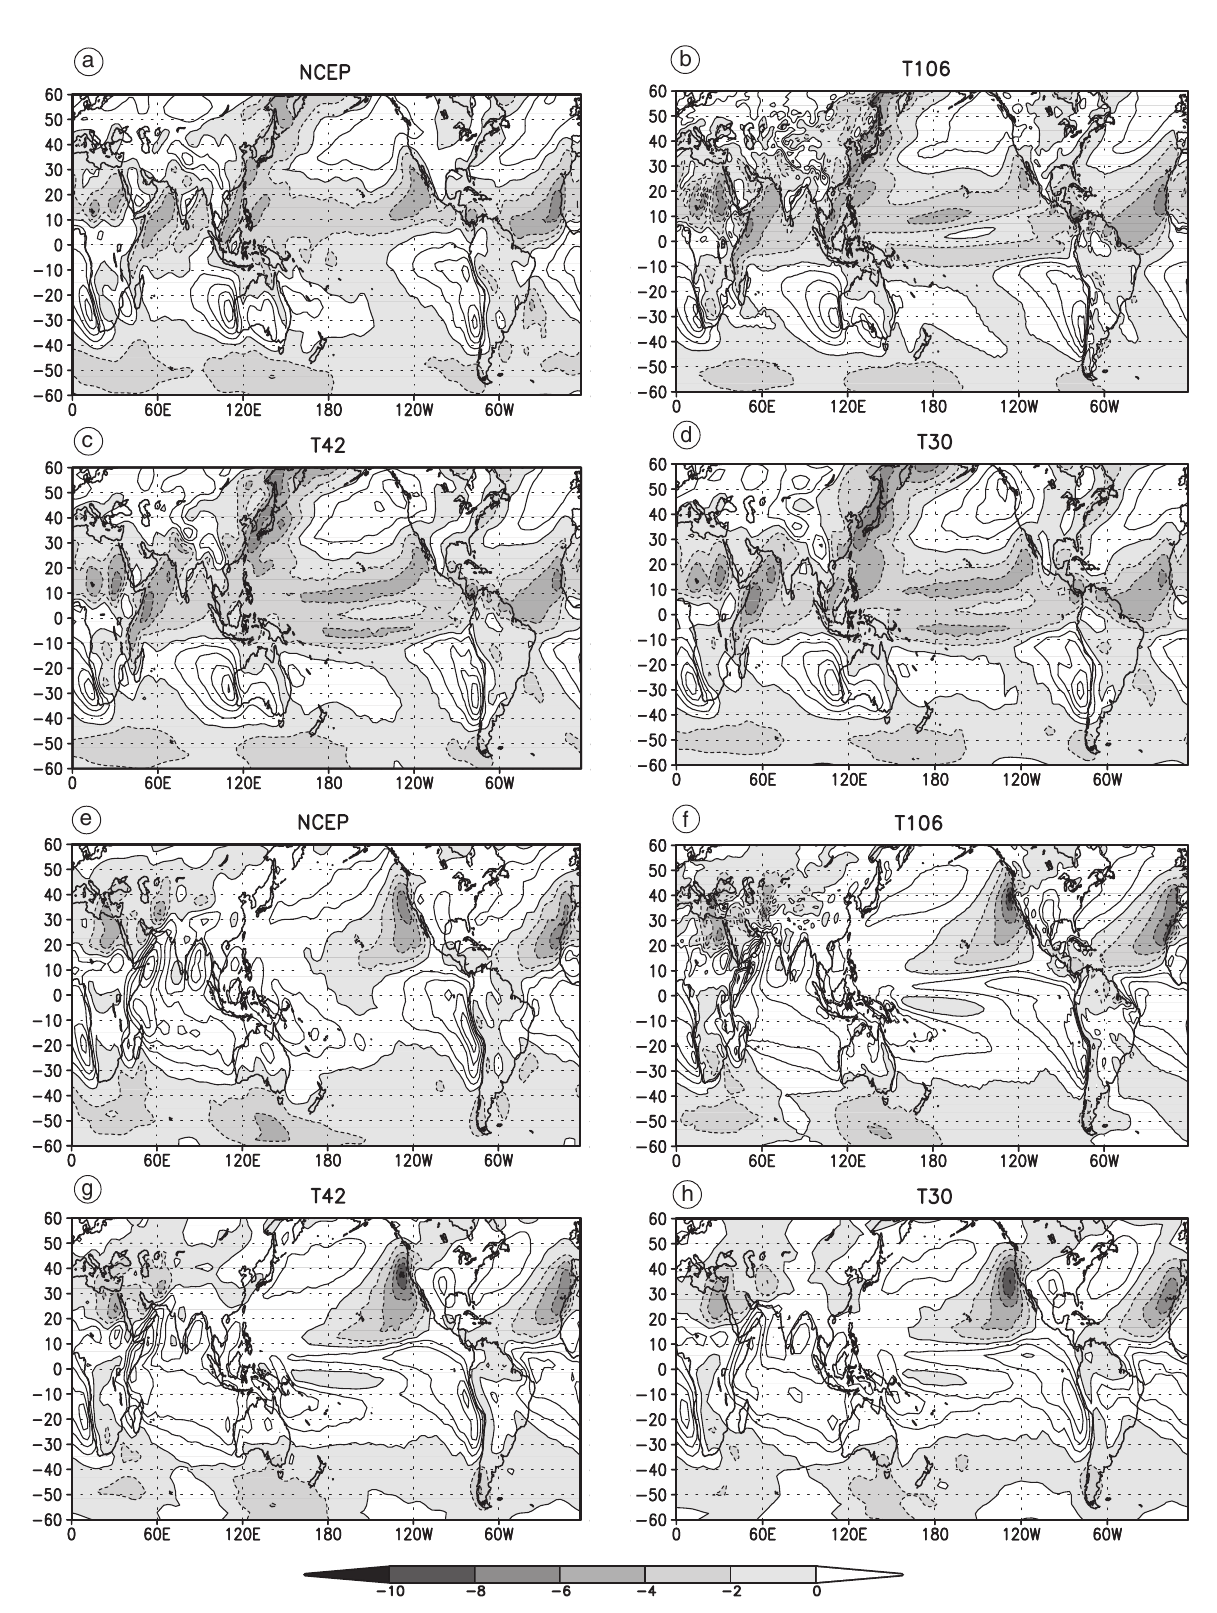
Fig. 5a-h. Same as fig. 4a-h, but for the meridional component of 1000-hPa wind. Contour interval is 2 m/s. Dashed contour lines and shaded areas indicate negative